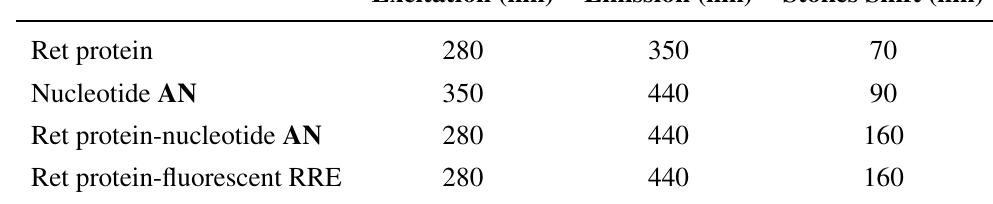
Intrinsic tryptophan fluorescence as the FRET donor with fluorescent (oligo)nucleotide [76]. Excitation (nm) Emission (nm) Stokes Shift